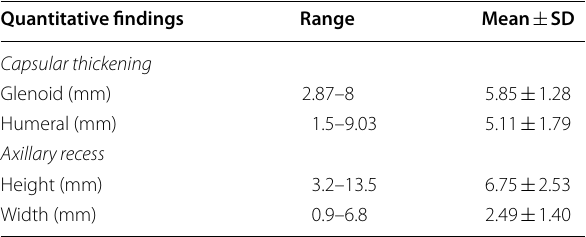
Table 4 Quantitative findings distribution among study